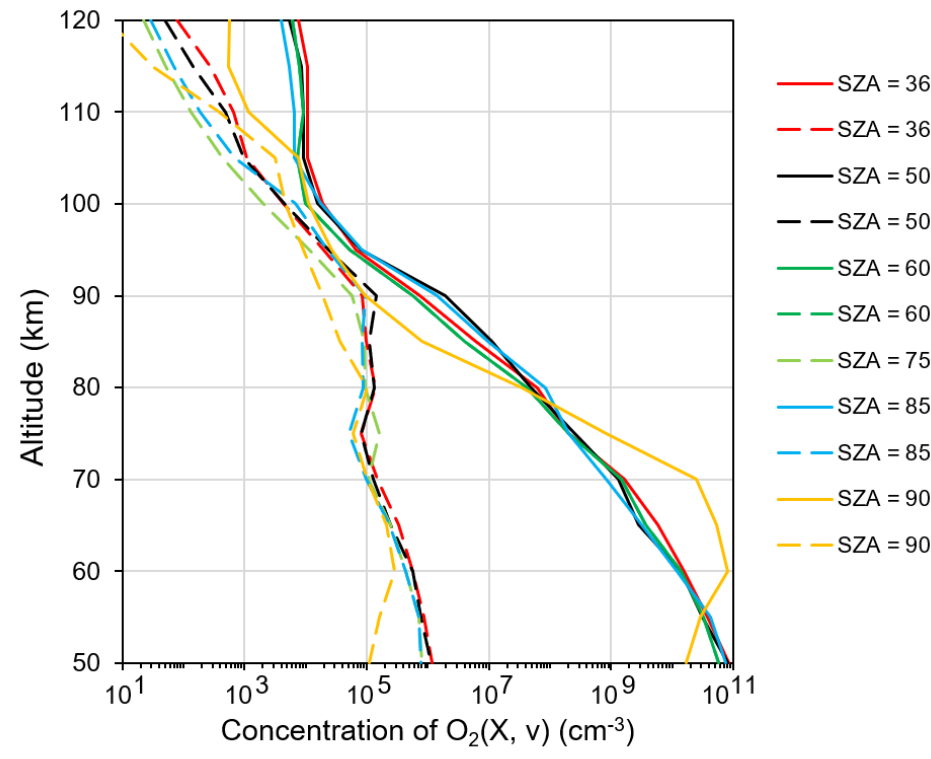
Figure 11. Altitude distributions of O 2 (X 3 Σ − g , v = 1) (solid curve) and O 2 (X 3 Σ − g , v = 2) (dashed curve) depending on solar zenith angle. Calculation is for SABER events during the vernal equinox 2002 using YM2011 model.